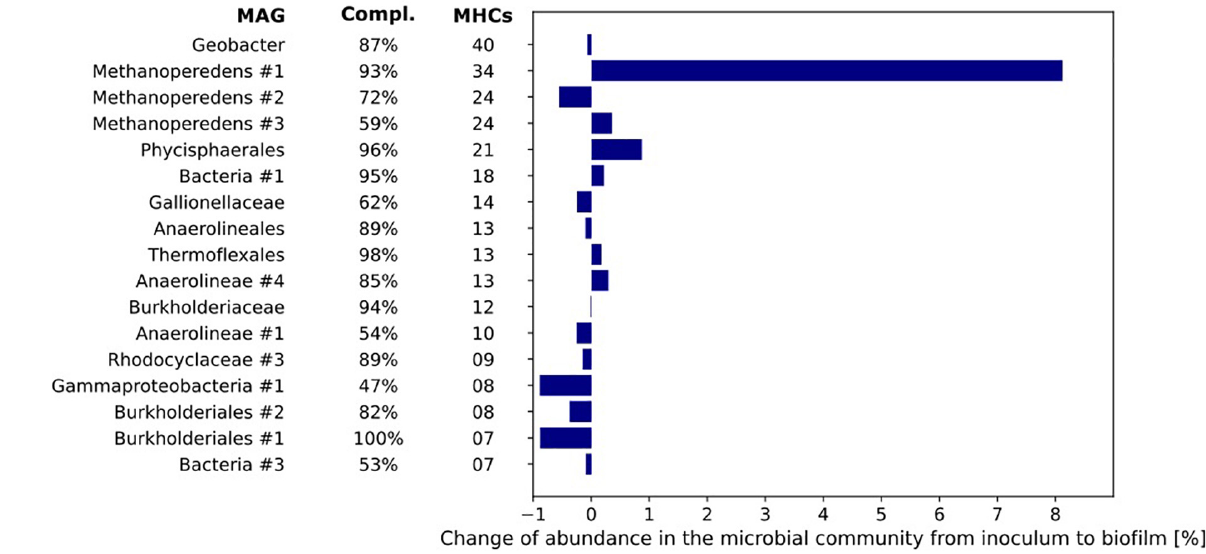
FIGURE 7 | The number of multiheme cytochromes (MHCs) harbored by the MAGs of the microorganisms with most MHCs (threshold of ≥ 4 MHC). The MAGs are sorted from top to bottom by their number of c -type cytochromes. The bar chart represents the differences in relative abundance of the MAGs in inoculum and biofilm based on coverage of the respective MAGs under both